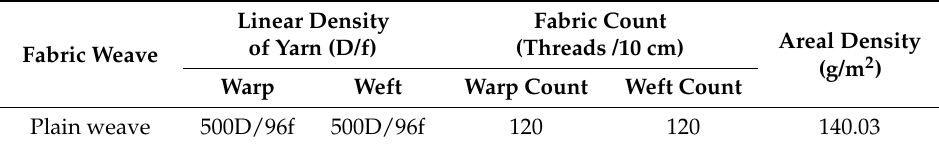
Figure 1. Images of PET filament tows and fabrics used in this work: ( a ) PET filament tows; ( b ) PET filament fabrics. Table 1. Structure parameters of PET fabric.